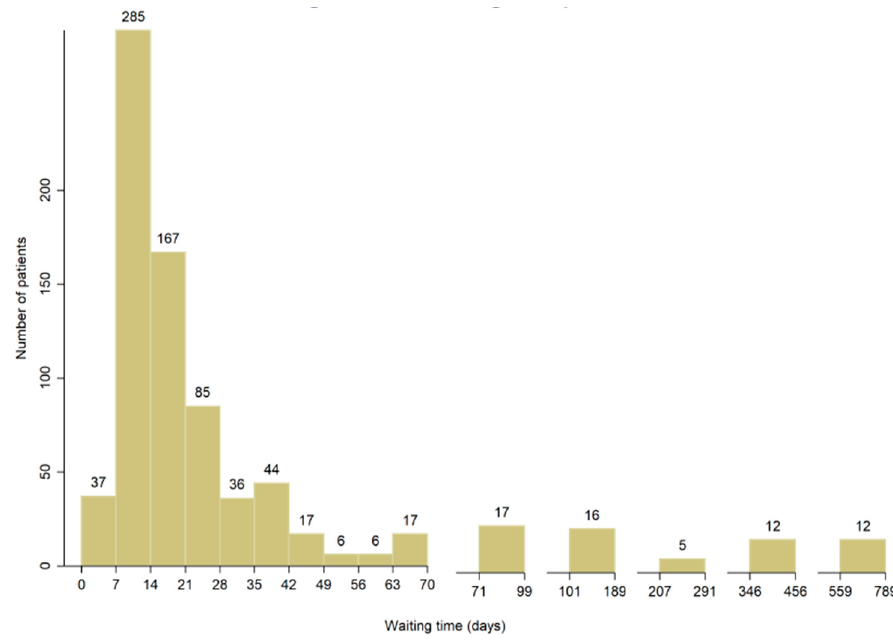
Figure 1. The distribution of TTS among T1 RCC patients. Table 2. Multivariable generalized linear regression of factors influencing TTS among all